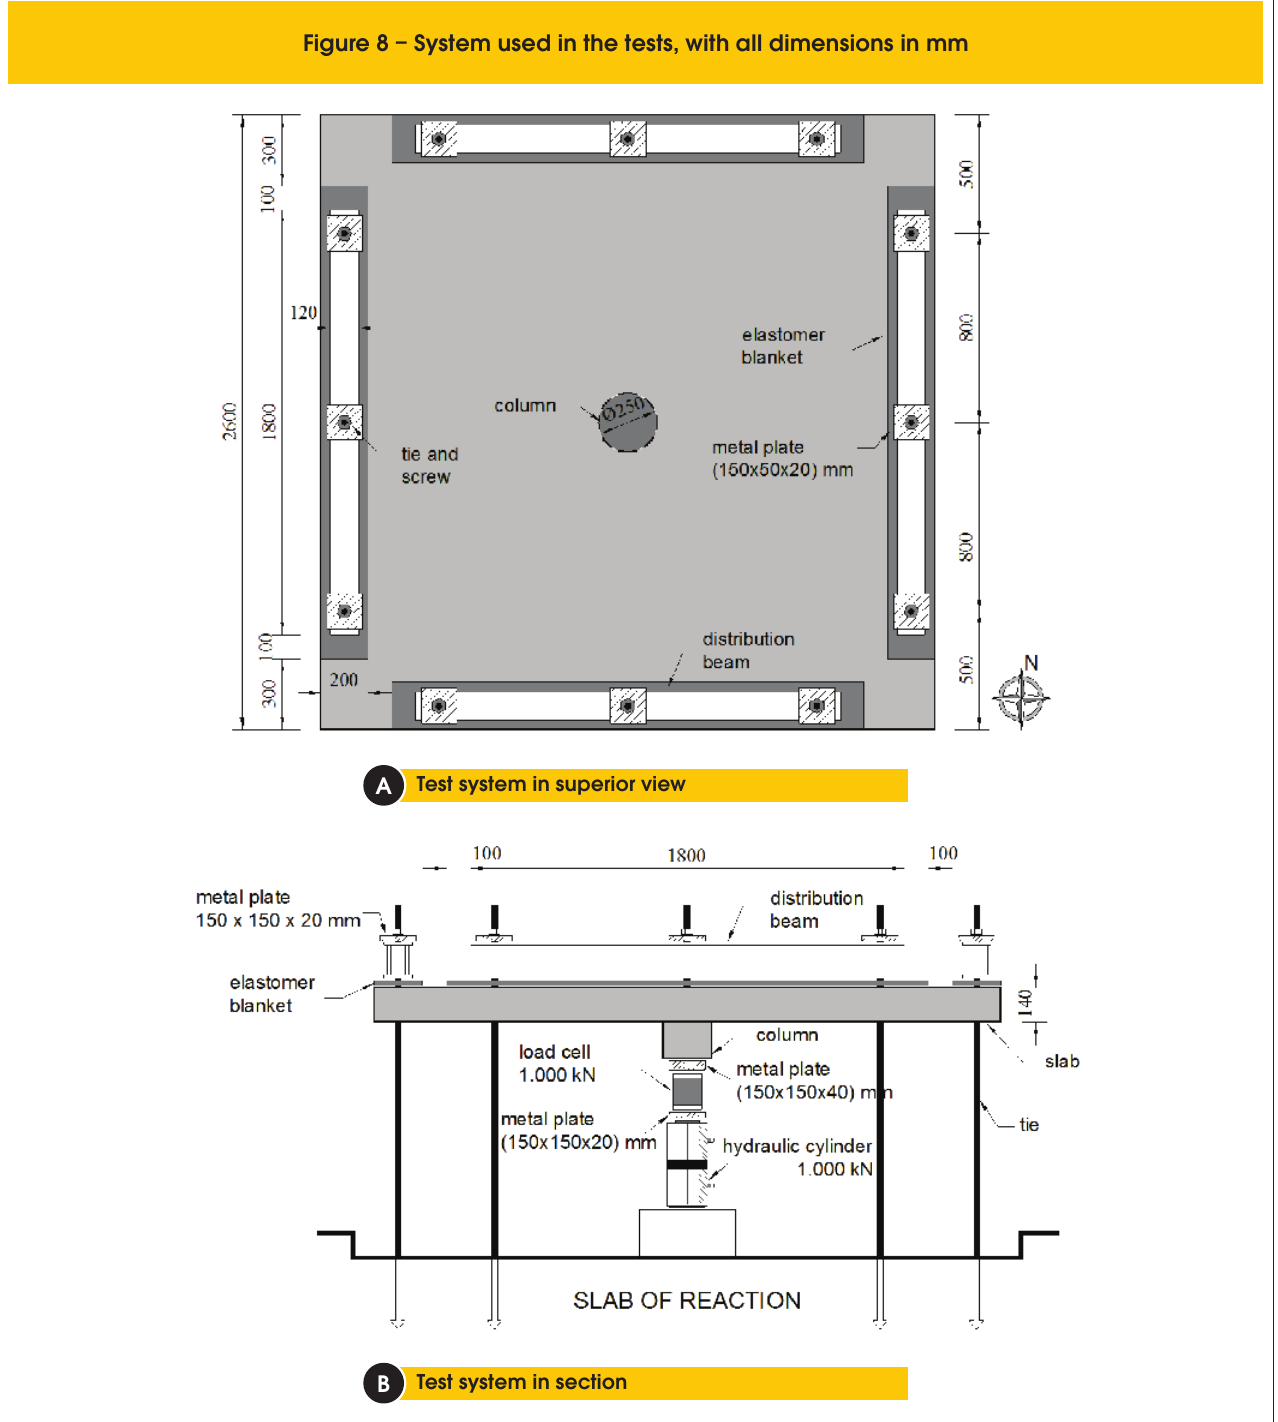
Figure 8 – System used in the tests, with all dimensions in